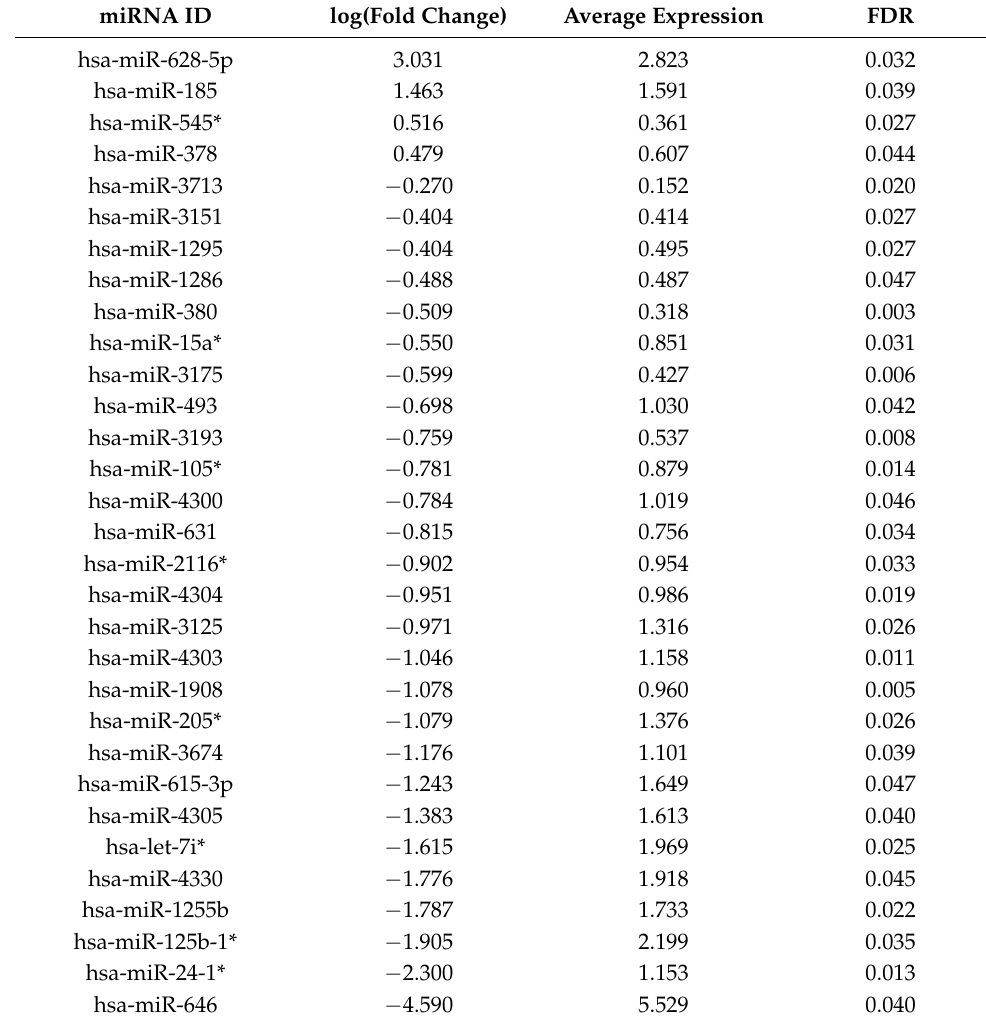
Table 2. Differentially expressed miRNAs in severe vs. mild/moderate BPD tracheal aspirates (Tas). miRNA